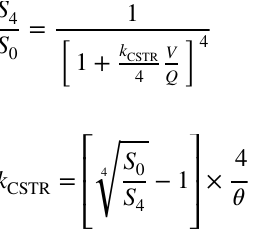
Table 1 BOD 5 and TKN in SSFCW for initial